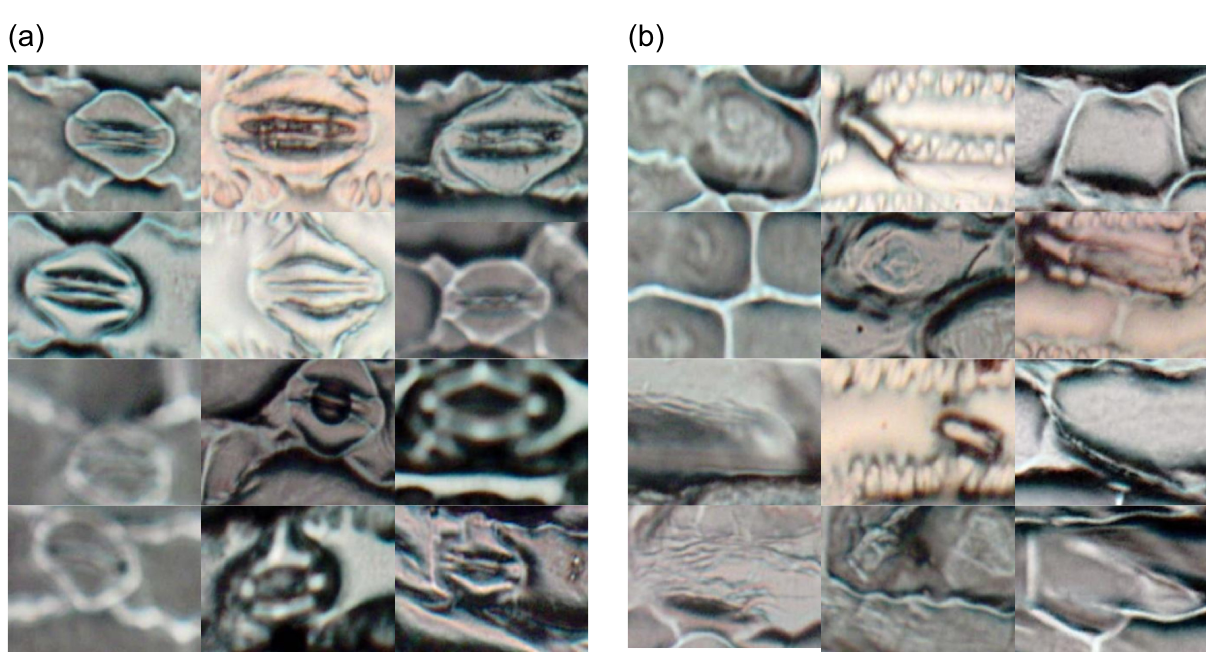
Fig 9. Examples of the stomata classification detection results, including (a) corrected labeled sub-images and (b) false positive results.